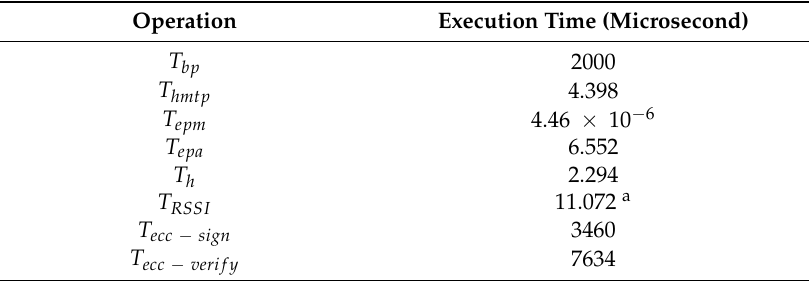
Table 3. Execution Time of Different Operations.